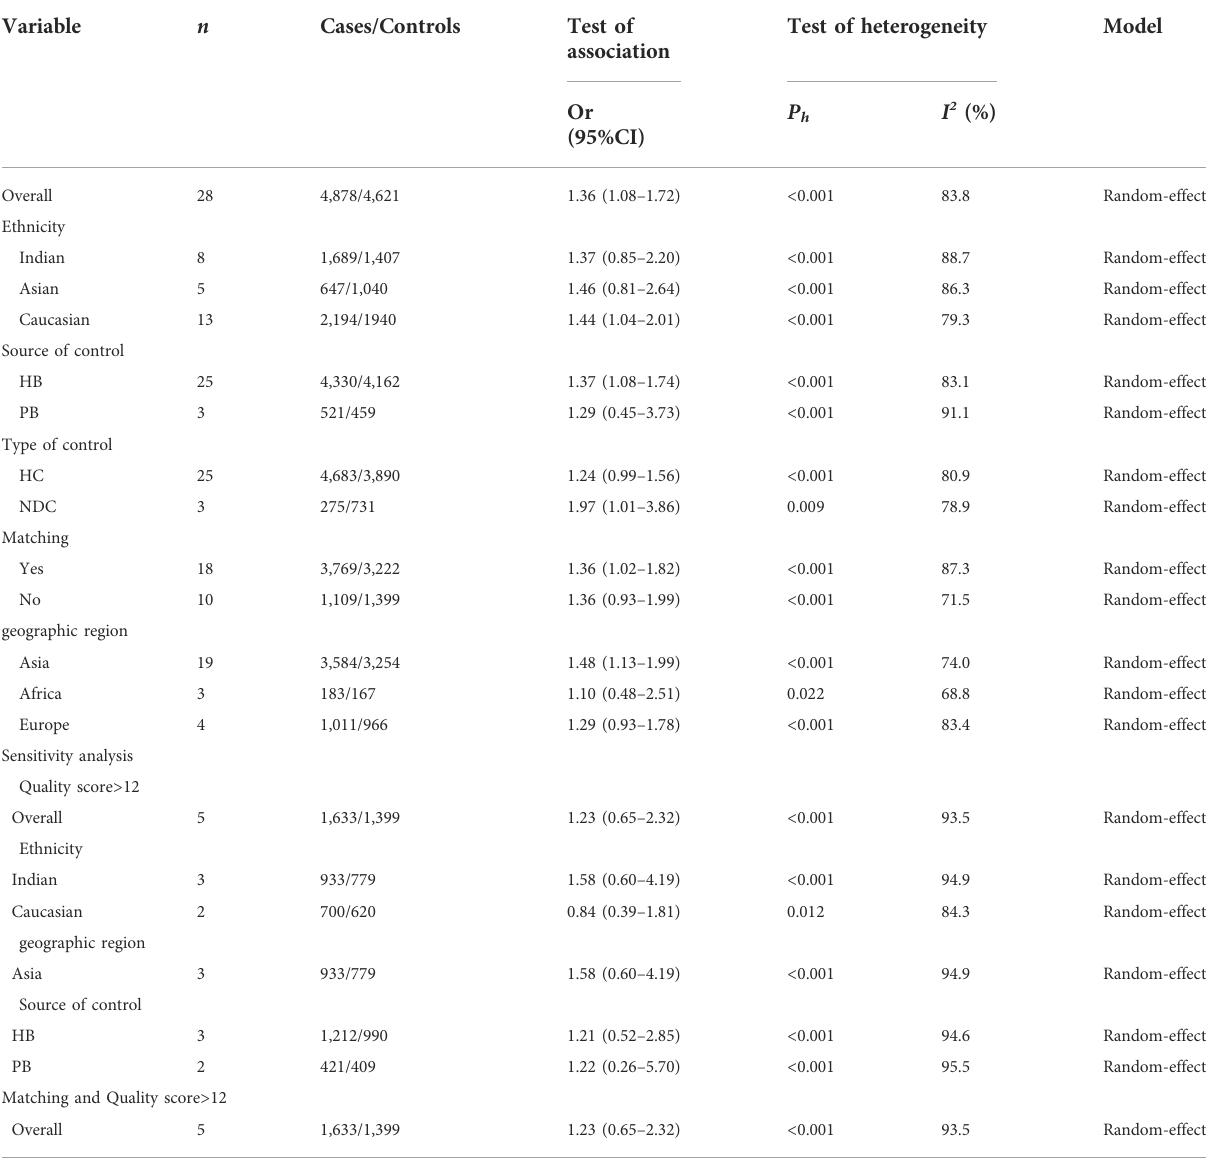
TABLE 1 Meta-analysis of the association of GSTM1 polymorphism with risk of